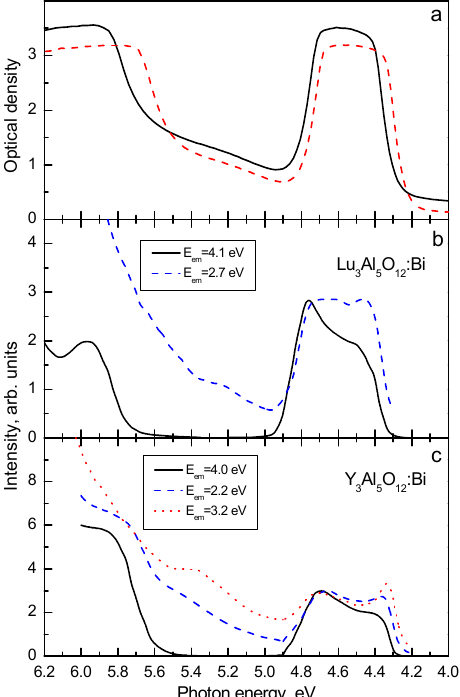
Figure 2. ( a ) Absorption spectra of Lu 3 Al 5 O 12 :Bi (solid line) and Y 3 Al 5 O 12 :Bi (dashed line) at 295 K. Excitation spectra (normalized) of ( b ) Lu 3 Al 5 O 12 :Bi and ( c ) Y 3 Al 5 O 12 :Bi measured at 80 K for different emission spectra regions shown in the legends. Based on the data reported in [16–18], presented with the publisher’s permission.